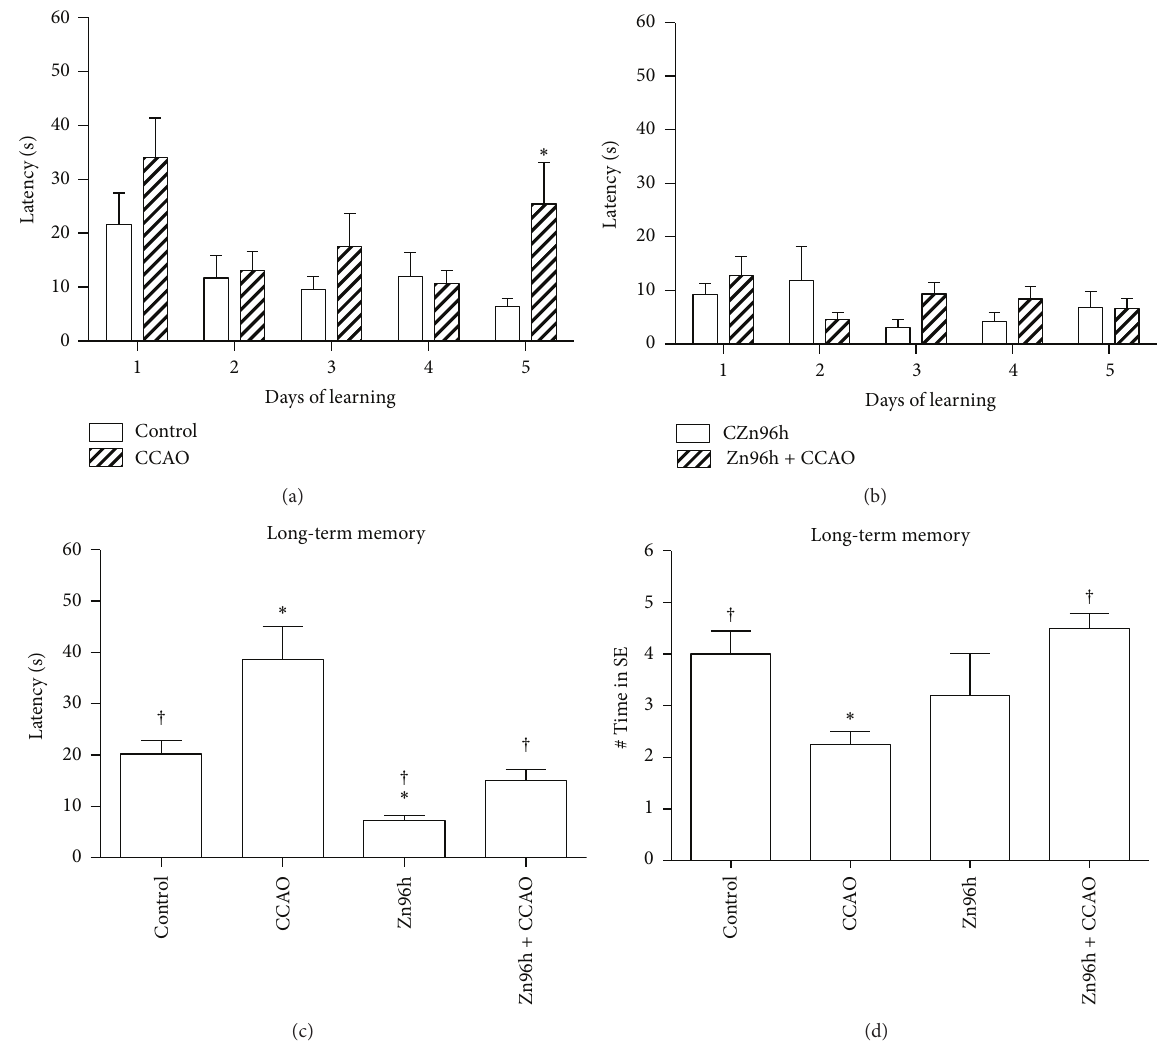
Figure 7: The effect of subacute administration of zinc on learning and long-term memory after hypoxia-ischemia in rats. ((a) and (b)) Graphs showing the latency to reach the escape platform in the fourth event (eastern quadrant) of a daily evaluation for five days in the Morris Water Maze ( 𝑛 = 10 rats per group). (c) Graphs showing the latency determined on day 7 after the learning training, that is, on day 12 after reperfusion ( 𝑛 = 5 rats per group). (d) Graphs showing the number of times in southeast (# Time in SE) at which rats pass by the platform location. Evaluations were made on day 7 after the learning training. The values are the mean ± SEM. ∗ , significant when compared with the control group ANOVA test and post hoc Dunnett’s test, 𝑃 < 0.05 . † , significant when compared with the CCAO group; unpaired Student’s 𝑡 -test. 𝑃 < 0.05